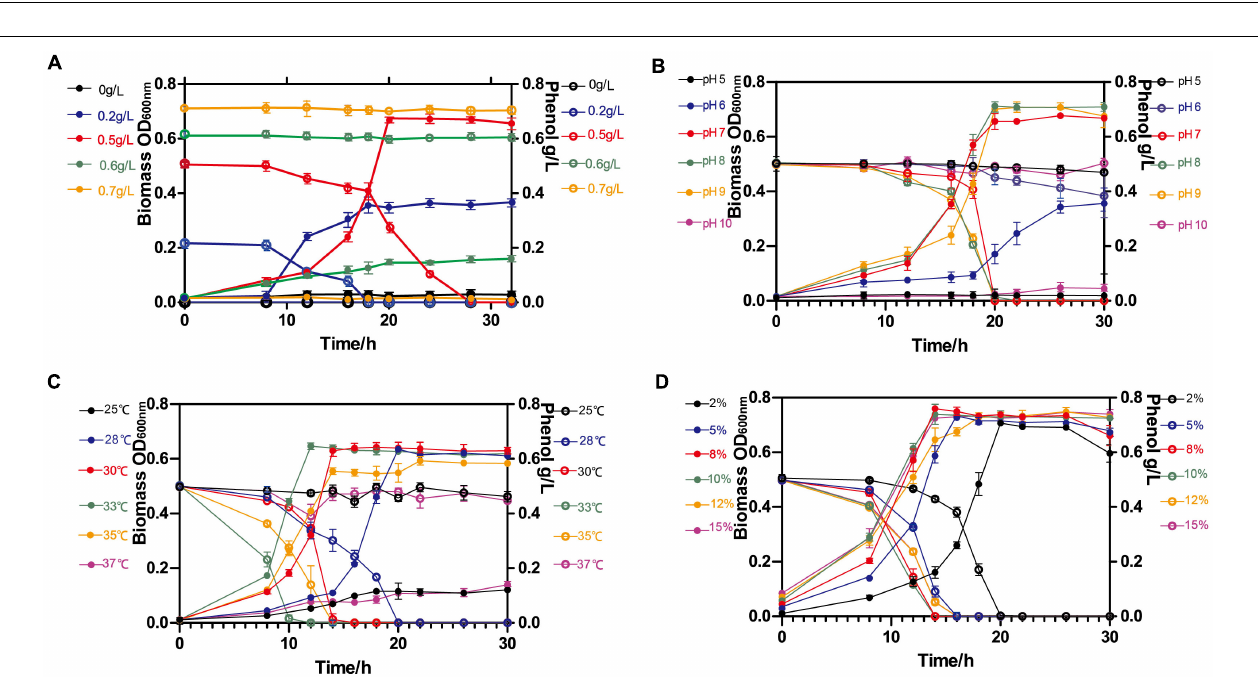
FIGURE 4 | Gene expression and catalytic activity of phenol degradation-related enzymes. (A) mRNA expression folds of LSNL_2975–2981 genes in A. lwoffii NL1 with phenol compared to cultures without phenol. (B,C) Phenol hydroxylase (B) and catechol 1,2-dioxygenase (C) expressed in E. coli BL21.